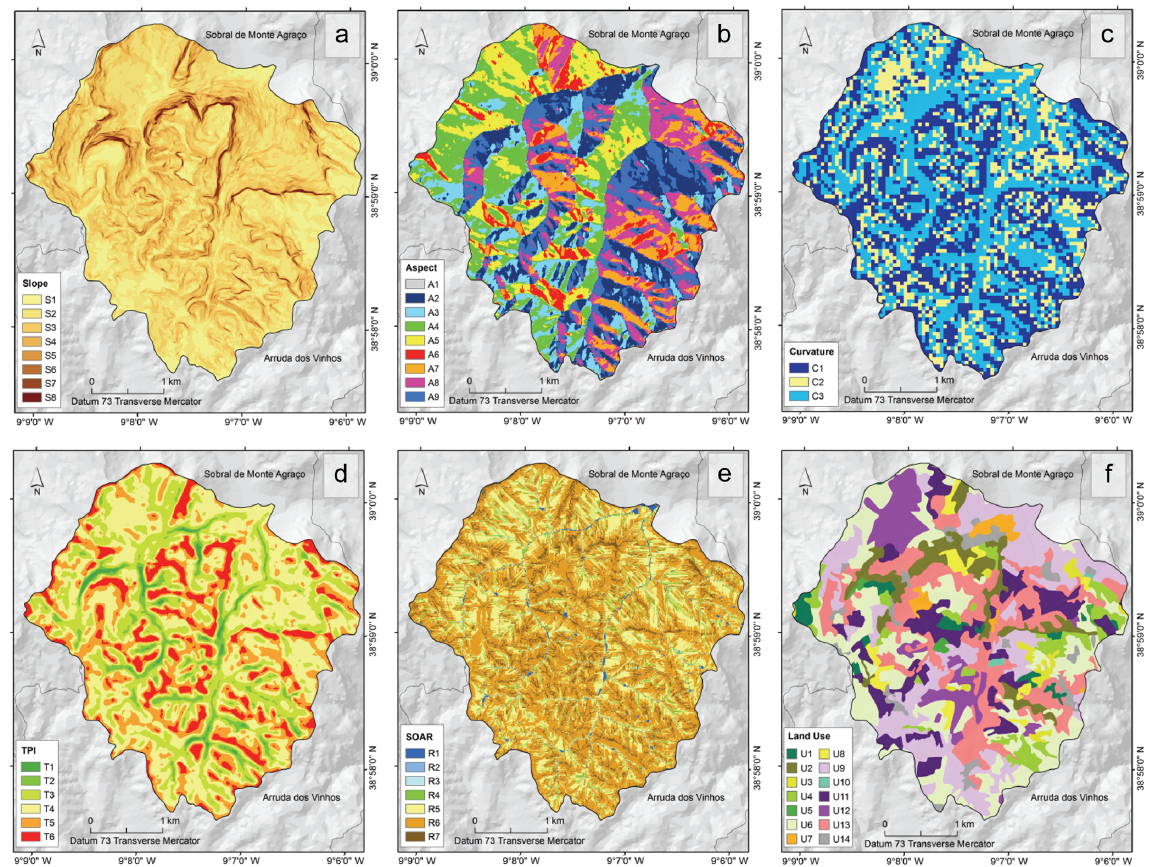
Figure 3. Dataset of shallow slide predisposing factors. (a) Slope, (b) aspect, (c) profile slope curvature, (d) topographic position index, (e) slope over area ratio, and (f) land use. Lithology is shown in Fig. 1, and the classes of landslide predisposing factors are described